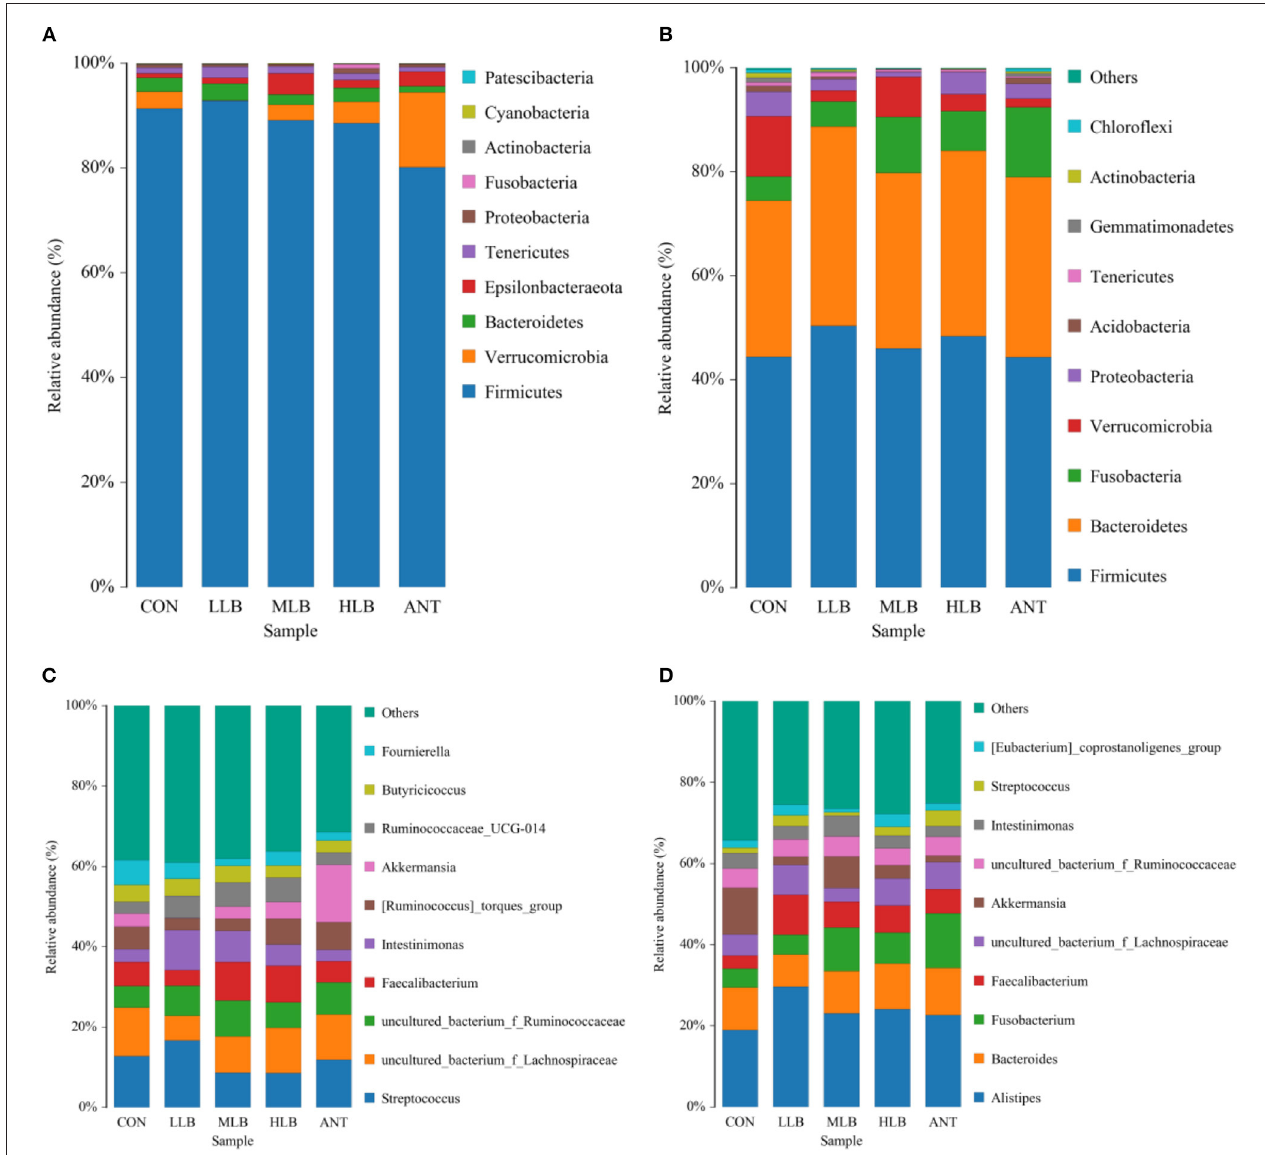
FIGURE 3 | Relative abundance (%) and composition of intestinal microorganisms at the phylum level and the genus level at different time points of Pekin ducks, n = 6 for each group. (A) 21 d at phylum level; (B) 42 d at the phylum level; (C) 21 d at the genus level; and (D) 42 d at the genus level. CON, control group, basal diet; LLB, basal diet + 200 mg/kg B. licheniformis ; MLB, basal diet + 400 mg/kg B. licheniformis ; HLB, basal diet + 800 mg/kg B. licheniformis ; ANT, basal diet + 150 mg/kg